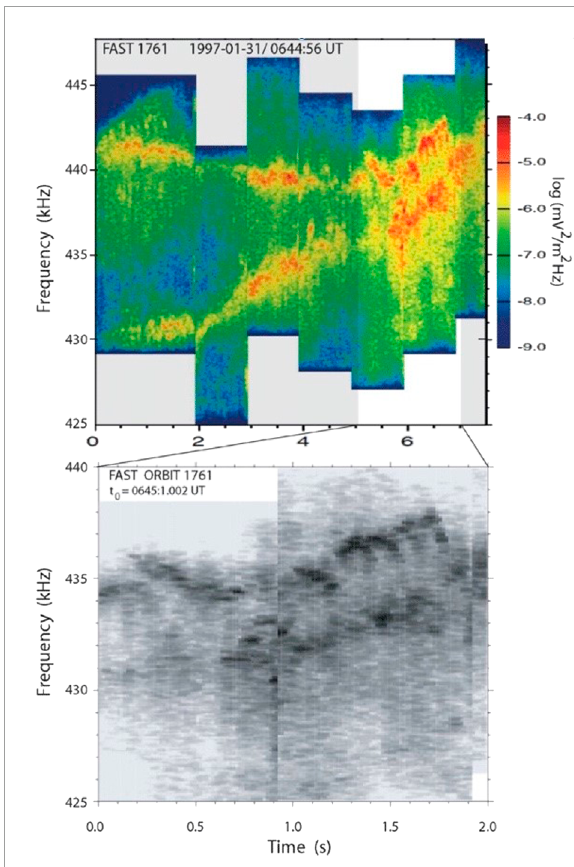
FIGURE 2 High time and frequency resolution FAST observations of the fine structure in the spectrum of AKR during passage of the auroral region [adapted from (Treumann et al., 2012)].